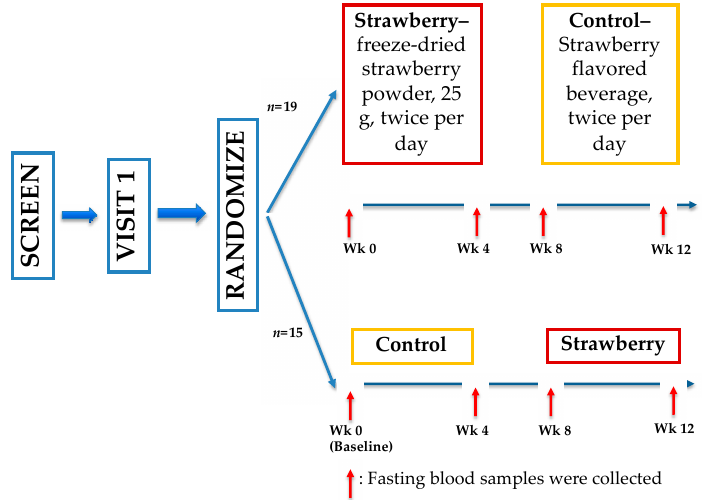
Figure 7. Study schema of the 4-week randomized, double-blind, placebo-controlled, crossover trial. Supplementary Materials: The following are available online at https://www.mdpi.com/2218-1 989/11/2/99/s1, Table S1: UHPLC-Q-TOF chromatograms of tentatively identified BAs in human plasma, feces, and urine samples, Table S2: BA standards used for quantification of individual BA metabolites, Table S3: Nutritional composition of control and strawberry beverage (per 50 g